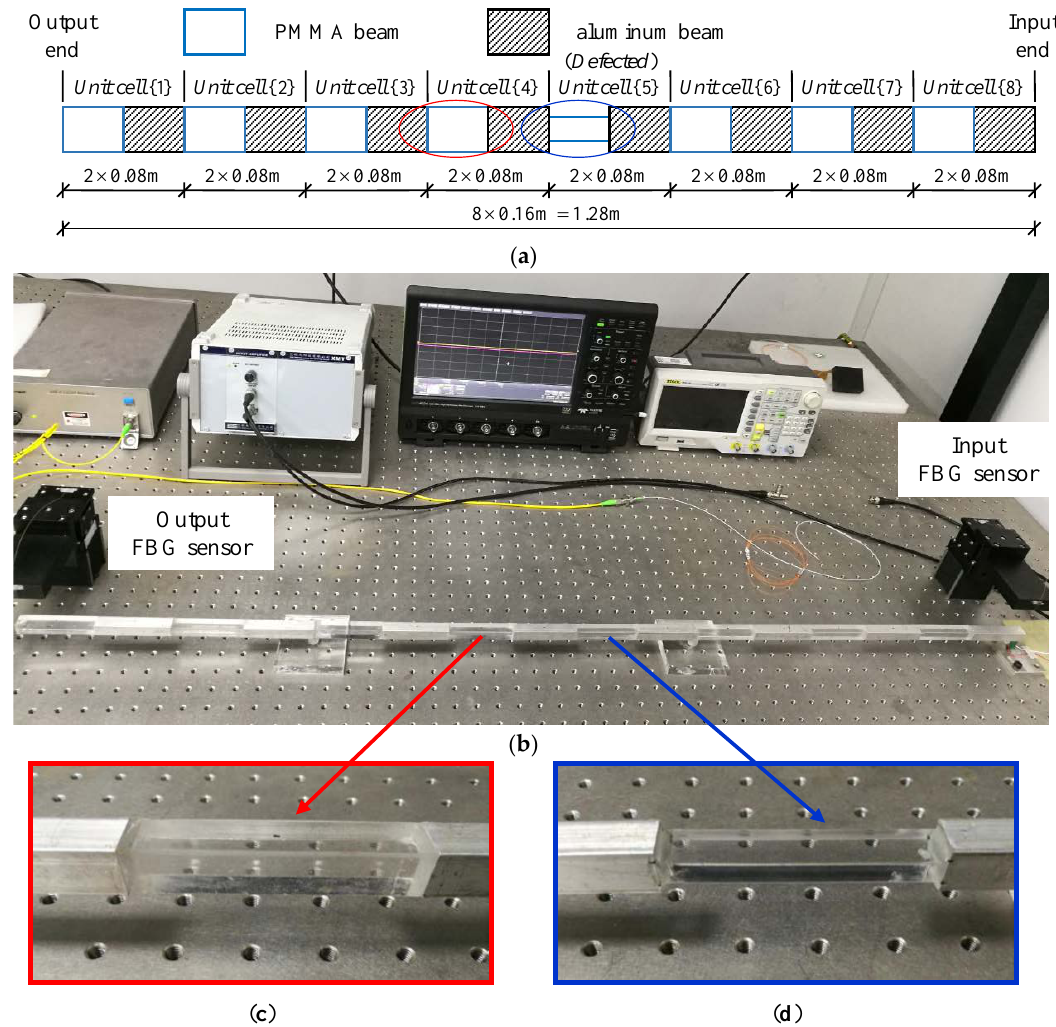
Figure 5. The defected phononic crystal beam with eight binary unit cells, each of which consists of a PMMA beam and an aluminum beam having identical length 80 mm: ( a ) The schematic of the structure; ( b ) The experiment specimen; ( c ) The PMMA beam in a perfect unit cell of the experiment specimen; ( d ) The PMMA beam in the defected unit cell of the experiment specimen.